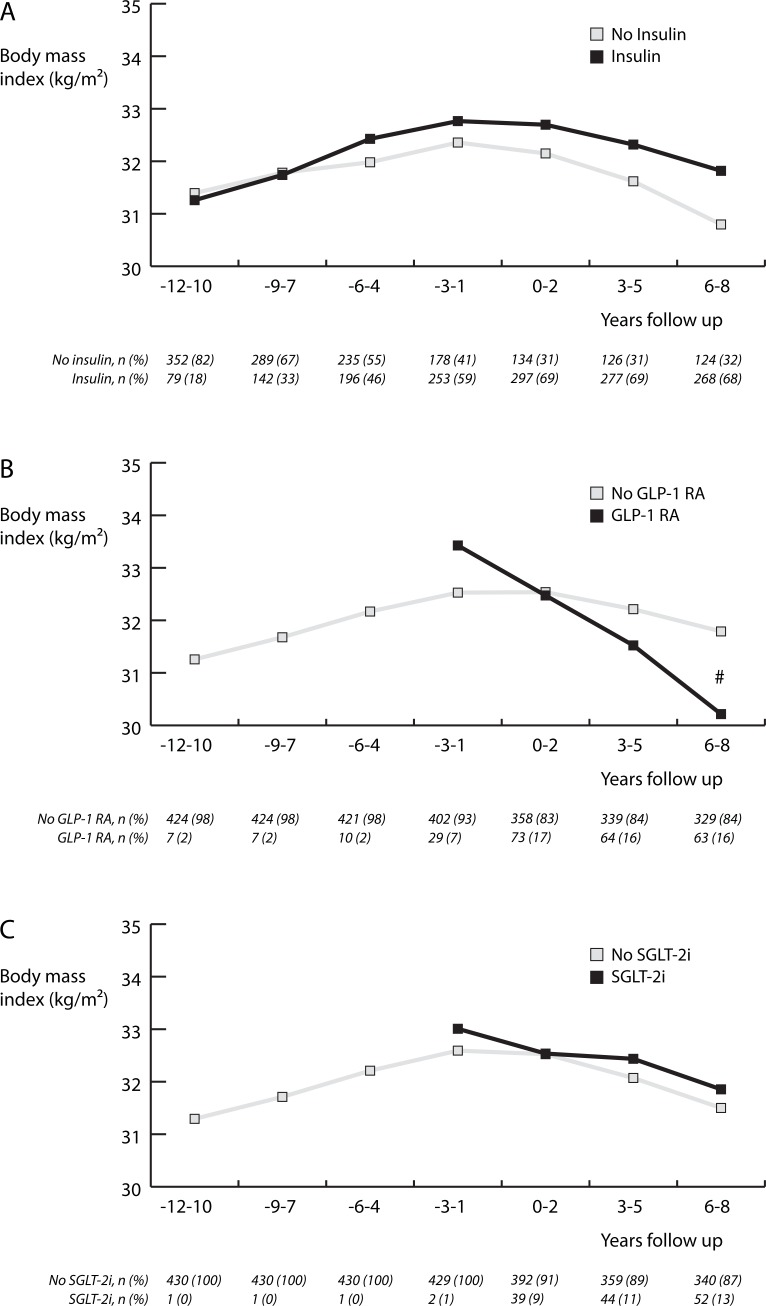
Weight course using estimated means by a break-up of A) insulin, B) GLP-1 RA and C) SGLT-2i use in patient with type 2 diabetes included in DIALECT-1. Estimated means were calculated using linear mixed model analyses. BMI course in patients who started on GLP-1 RA was significantly different from those who did not (Pinteraction = 0.003). There was no difference in overall BMI course between the insulin groups (Pinteraction = 0.46) and SGLT-2i groups (Pinteraction = 0.83). # Significant difference in estimated mean BMI between the groups. GLP-1 RA, glucagon-like peptide-1 receptor agonists; SGLT-2i, sodium-glucose-cotransporter-2 inhibitors.